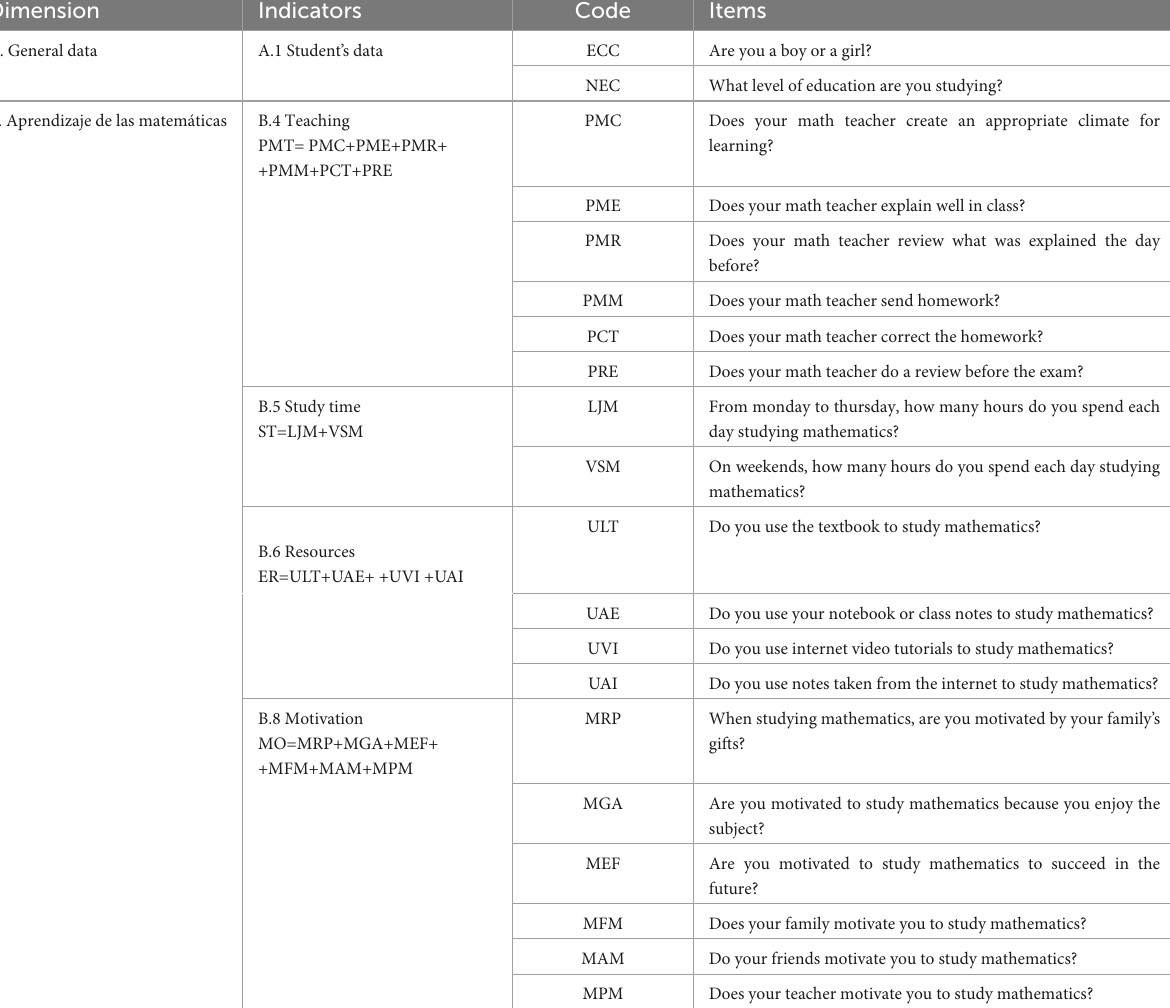
TABLE 1 Relation between motivation study dimensions, indicators, and items.